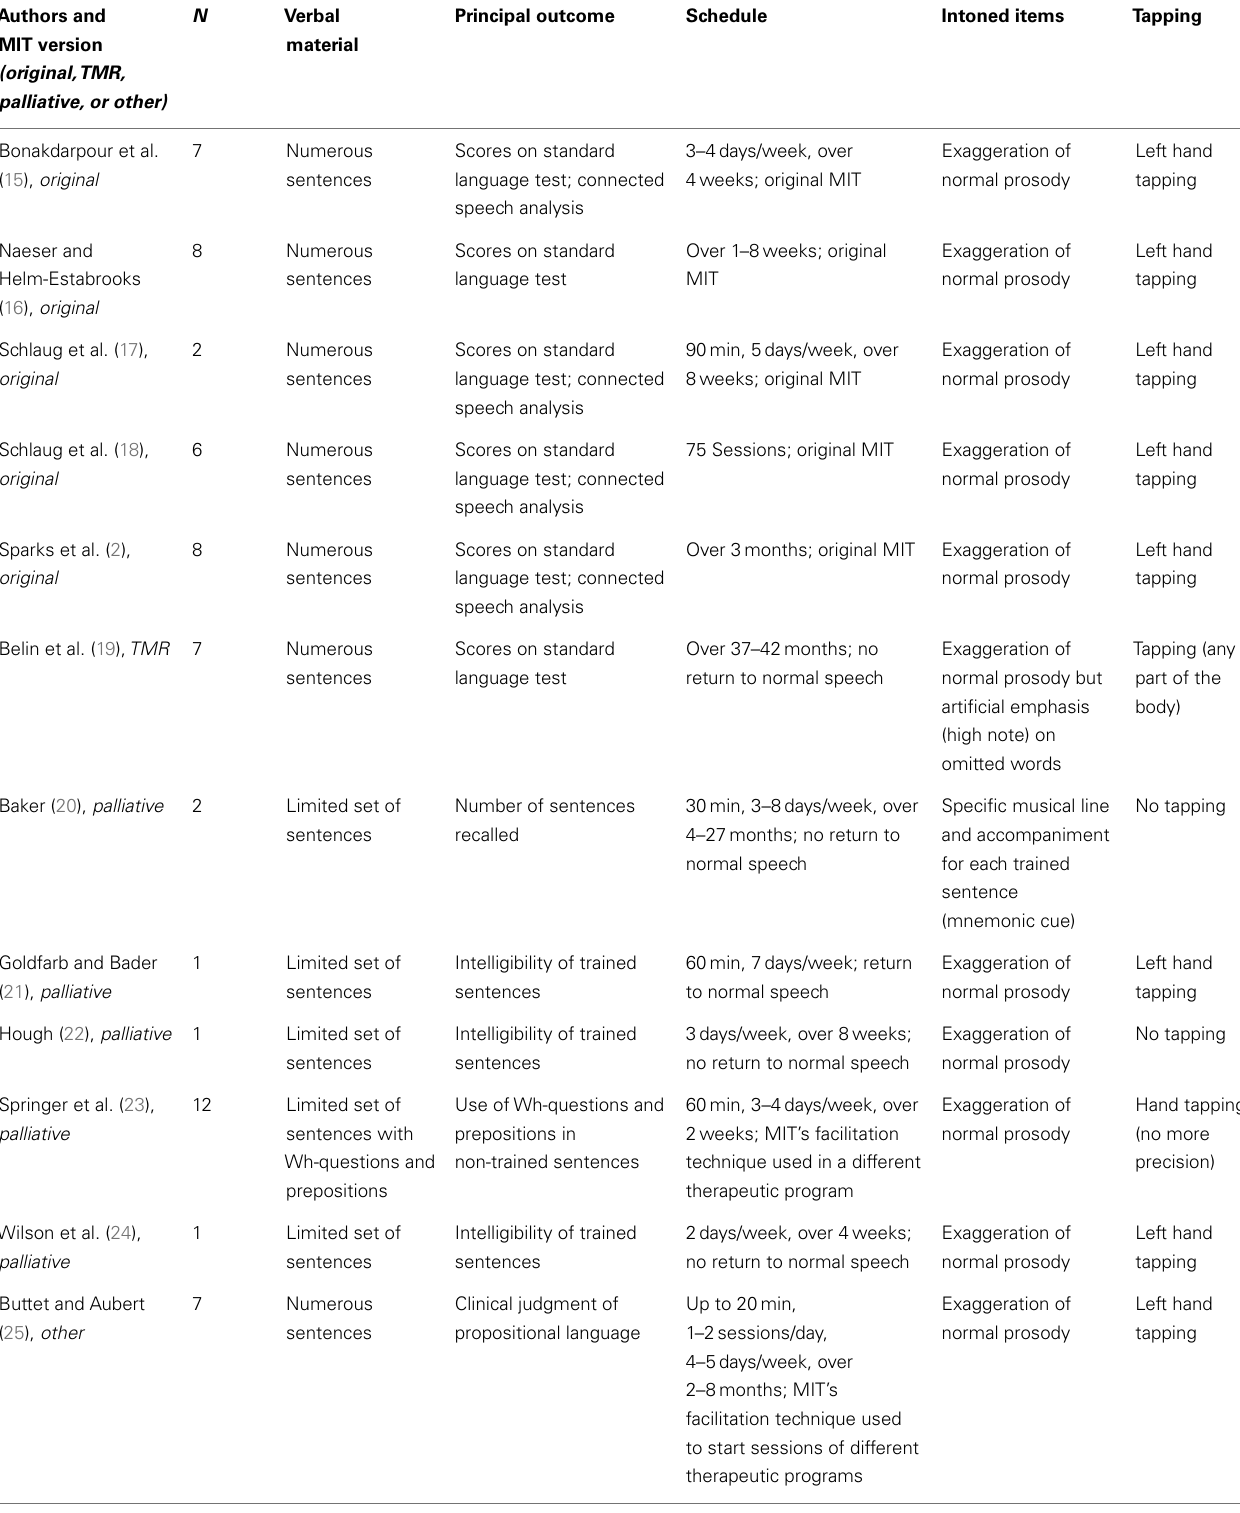
Table 1 | Some characteristics of the therapeutic protocols regarded as MIT in systematic